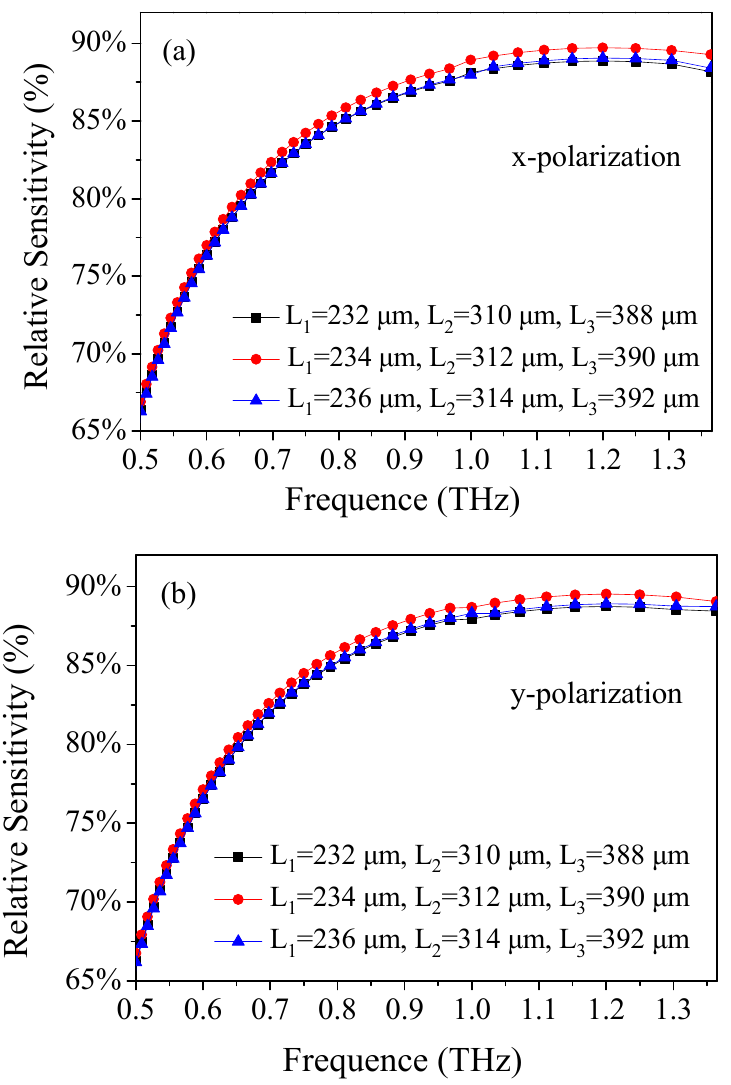
Figure 5. Frequency dependence of the relative sensitivity of ( a ) x- and ( b ) y-polarization for the length of rectangular porous core (L i ).